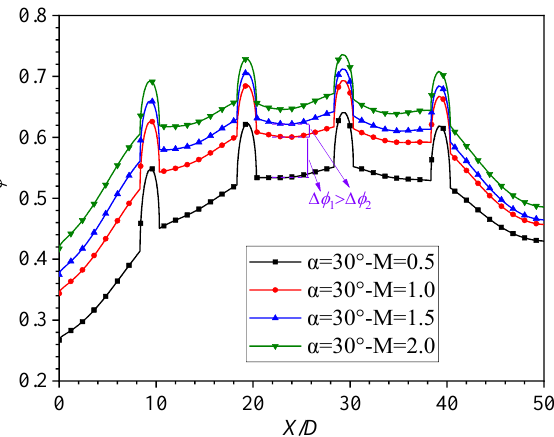
Figure 9. Laterally averaged overall cooling effectiveness for cases with α = 30° at different values of M .